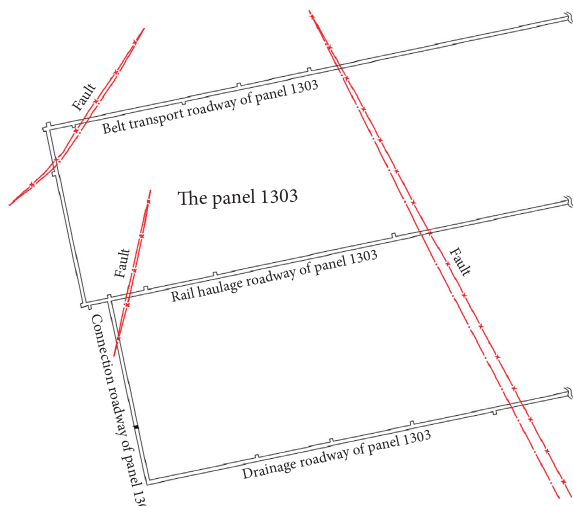
Figure 2: Layout sketch of panel